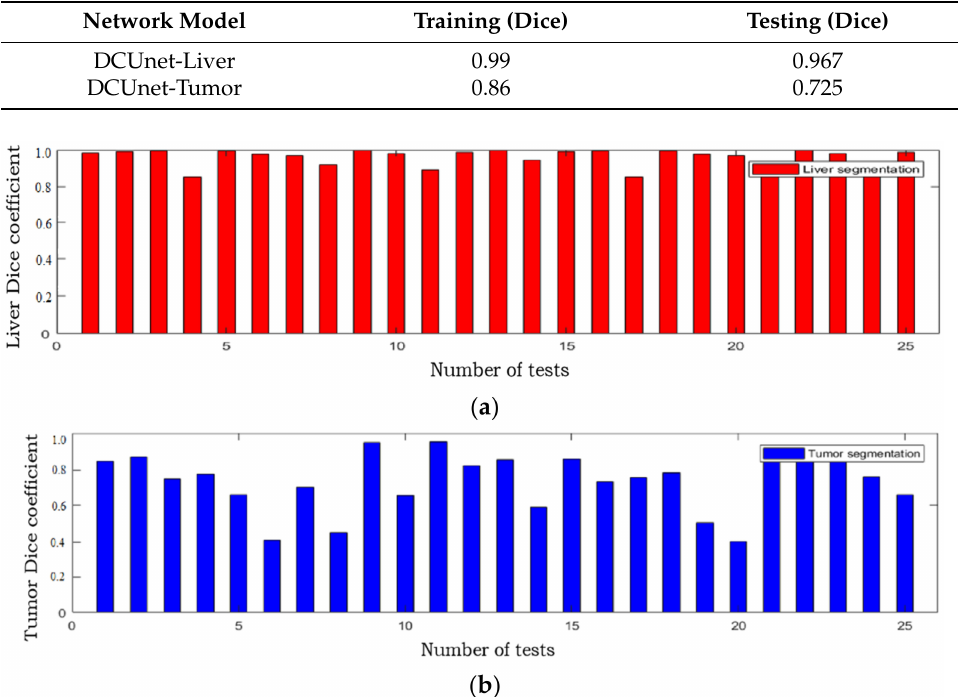
Table 4. The Dice coefficient of liver and tumor on the training and the testing dataset.